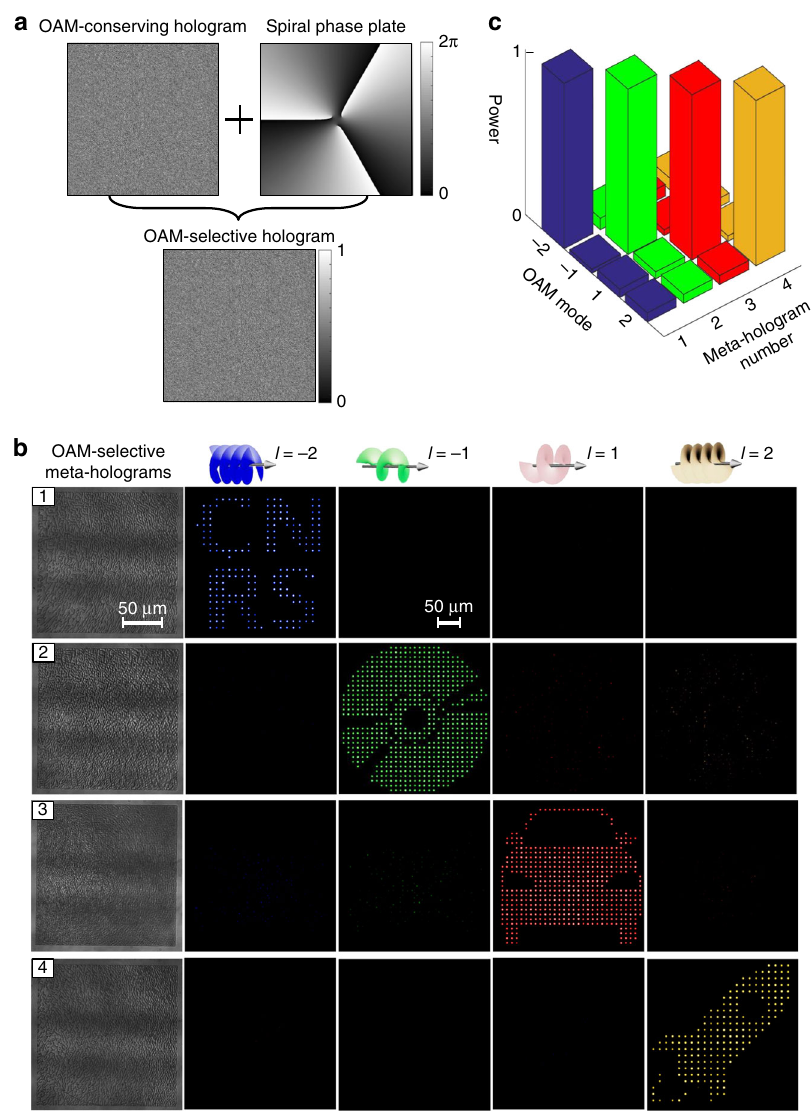
Fig. 3 Design and characterization of OAM-selective meta-holograms. a Design principle of an OAM-selective hologram by adding the phase function of a spiral phase plate onto an OAM-conserving hologram. b Experimental characterization of OAM-selective meta-holograms, which are labelled as “ 1 ” , “ 2 ” , “ 3 ” , and “ 4 ” , based on the illumination of the four OAM beams with topological charges of − 2, − 1, 1, and 2, respectively. c Comparison of optical power of the reconstructed holographic images using different OAM beams, which suggests the strong OAM selectivity by different OAM-selective meta-